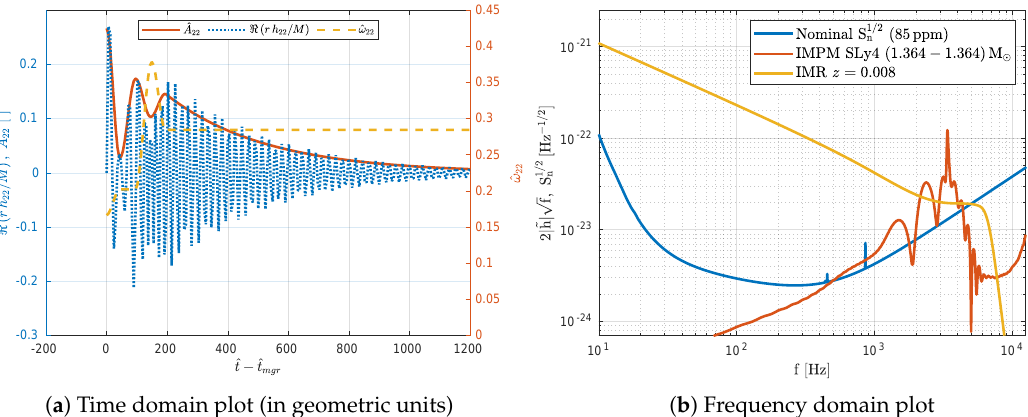
Figure 4. ( a ) Reproduction of time domain post-merger waveform following the numerical model by Breschi et al. [20]. The SLy4 equation of state reported by the authors in the left plot (green curve) of their Figure 5 is reproduced here. Units are geometric and scaled to total binary mass. ( b ) Frequency domain post-merger only waveform (red) and equivalent binary neutron star (BNS) inspiral-merger-ringdown (IMR) waveform (yellow), both at redshift 0.008. A nominal detector sensitivity with 85ppm round trip losses is also shown (blue). In this example, ρ and R are 3.20 and 256Mpc, respectively.